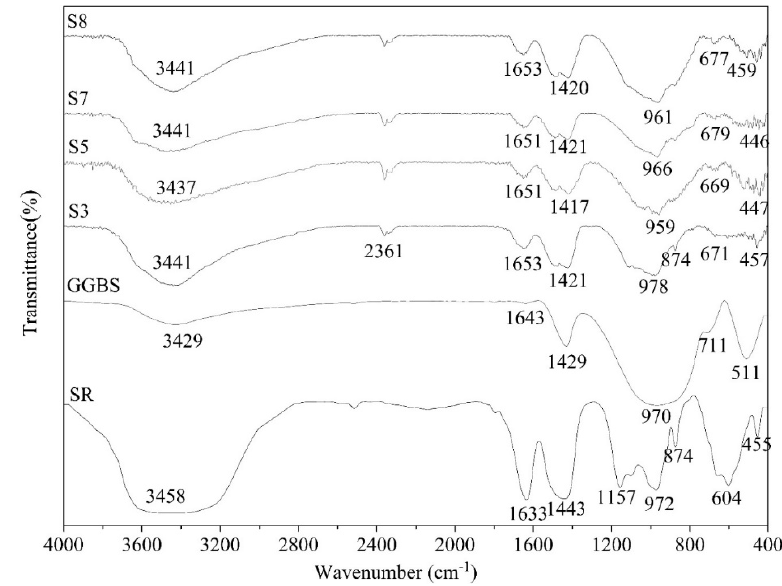
Figure 8. FTIR spectra of raw SR, raw GGBS, S3, S5, S7, and S8.